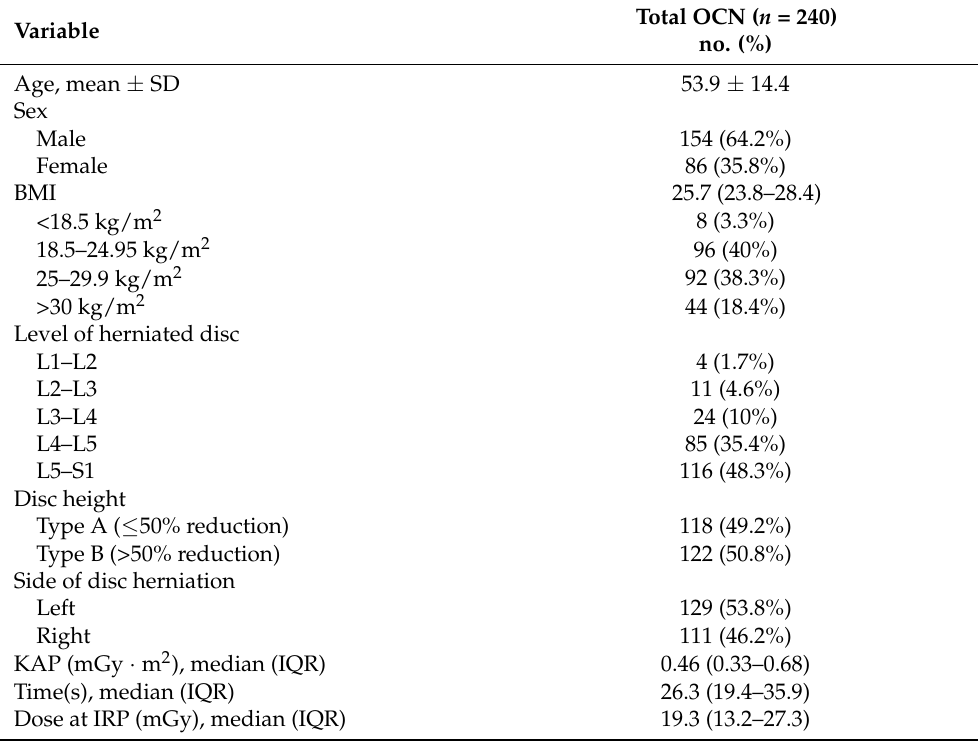
Table 1. Characteristics of the herniated lumbar discs and radiation